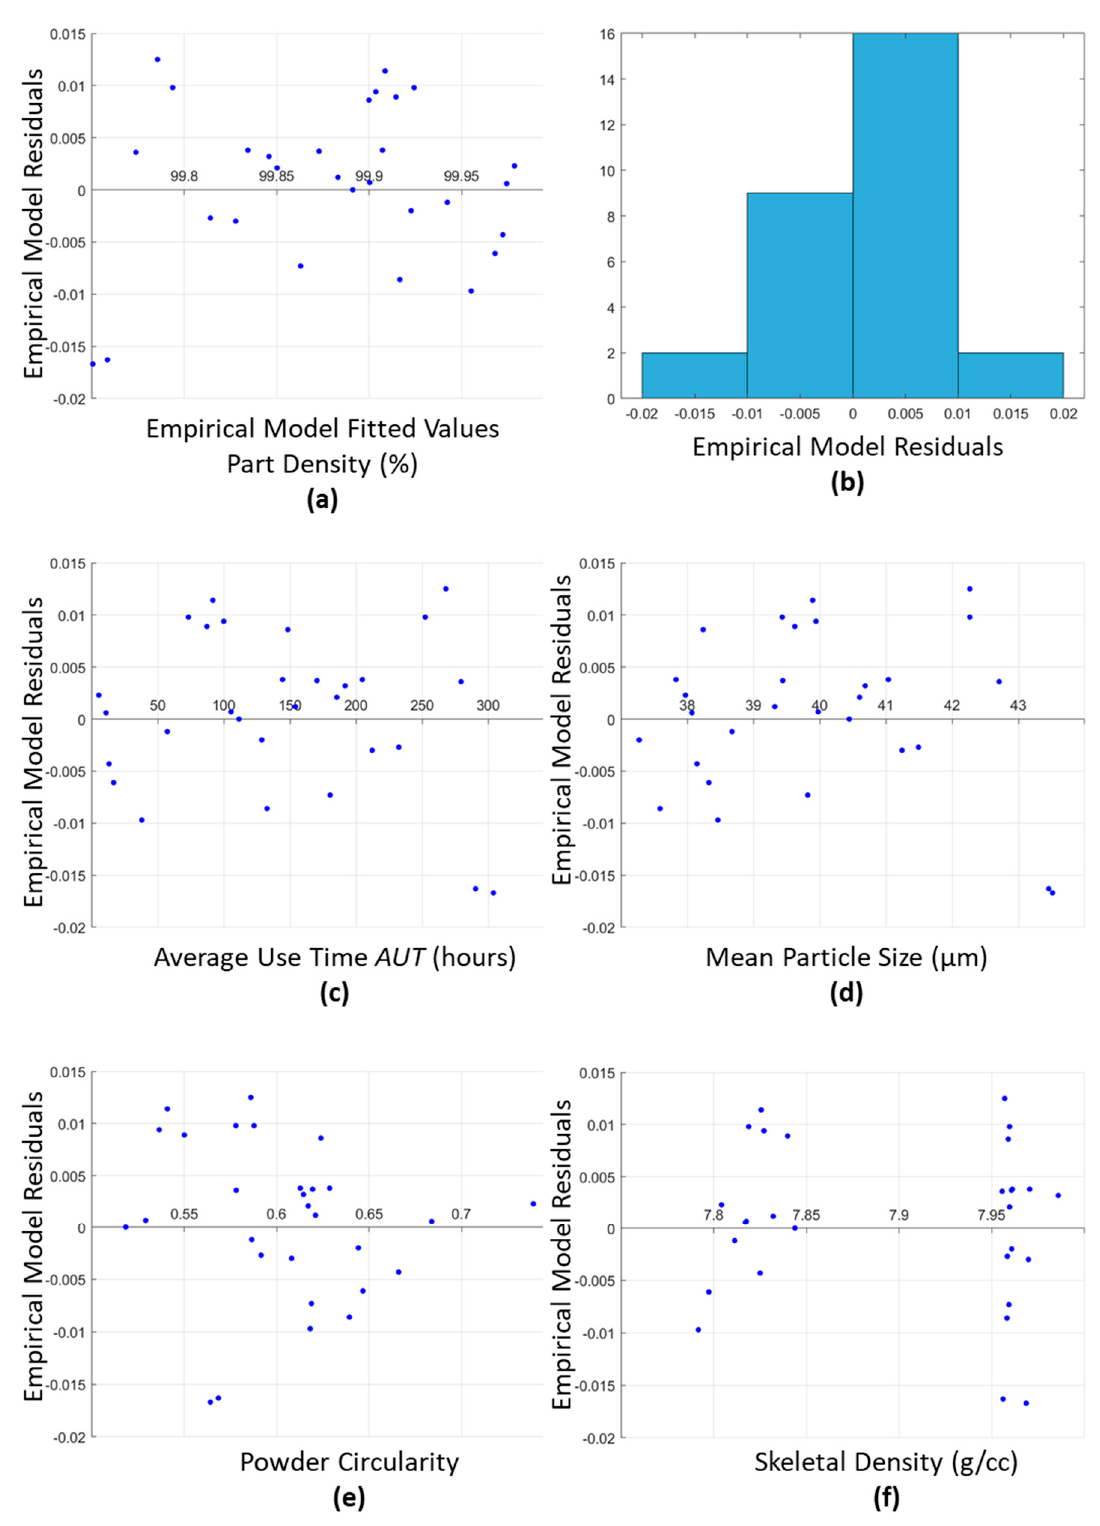
Figure 7. Part Density MLR Model results of the initial assumption tests to determine the validity of the model developed. the model